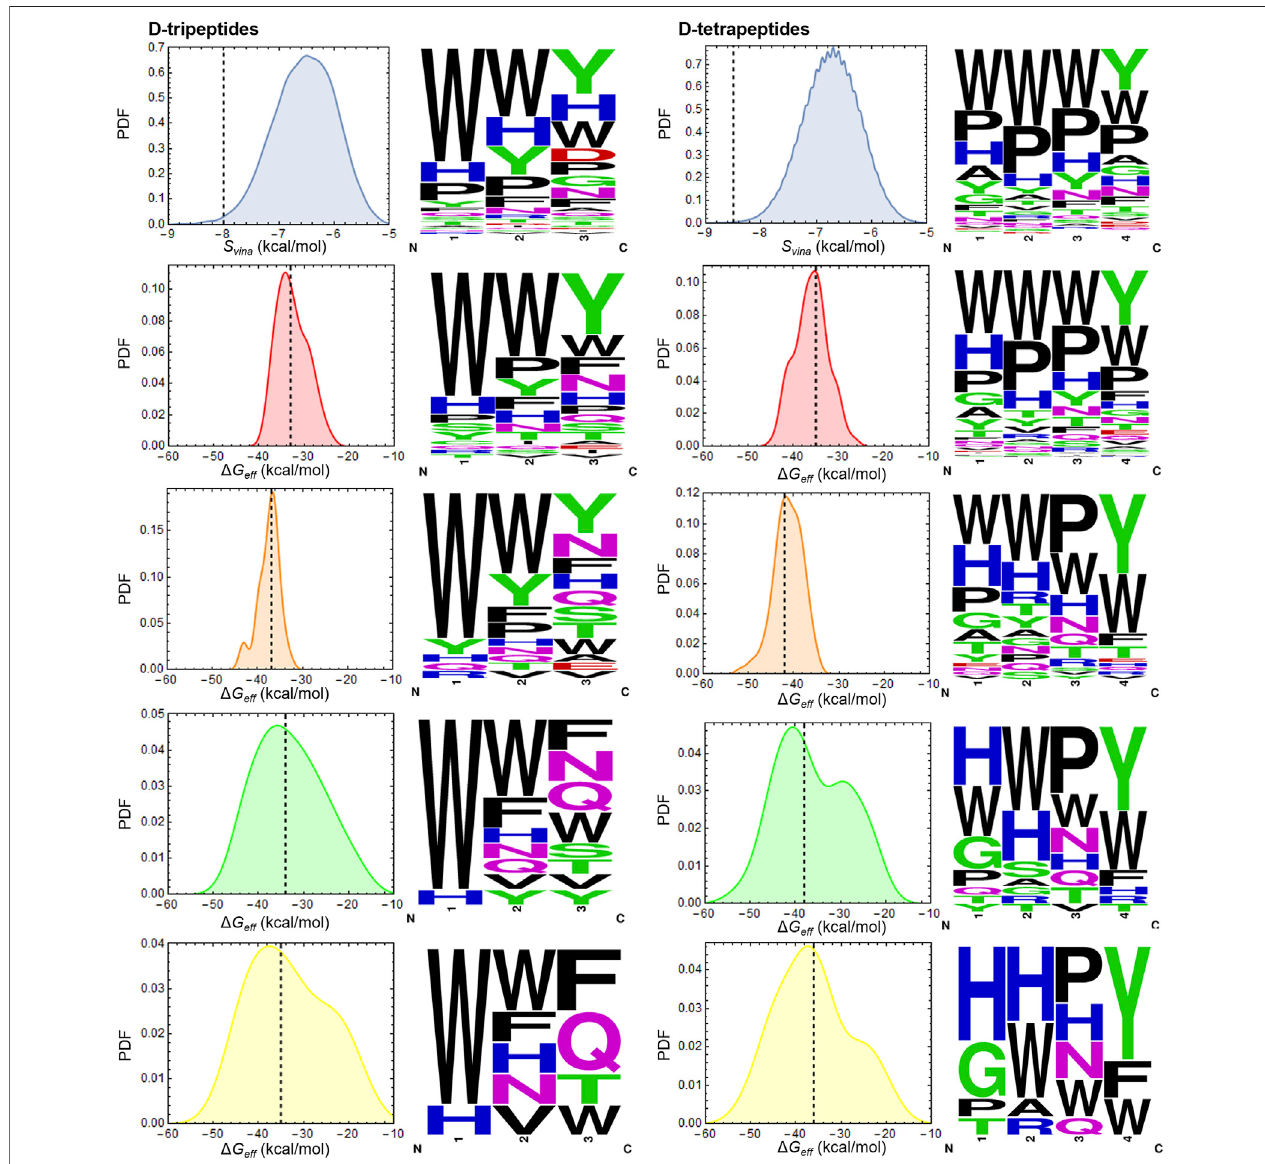
FIGURE 2 | Energy distributions and D-peptide sequences at every step of the in silico work fl ow. Each histogram is colored as the corresponding step of the work fl ow shown in Figure 1 . Dashed lines indicate the cut-off values employed to select the best candidates at every step. Peptides with S vina / Δ G eff values to the left of thedashedlineswereselected.PDFistheabbreviationforprobabilitydensityfunction.SequencelogosoftheD-peptidesidenti fi edateverystepareshowntotherightof the corresponding histograms. Letter sizes are proportional to the frequency of occurrence of the indicated residues in each position. N and C below the graphs stand for the N- and C- termini, respectively. Sequence logos were generated at https://weblogo.berkeley.edu/logo.cgi. A D-tetrapeptide was excluded as potential 3CL pro inhibitor after fi ltering according to the RMSD value in the last rescoring step ( Figure 1 , not shown). The last sequence logo of D-tetrapeptides does not contain the excluded